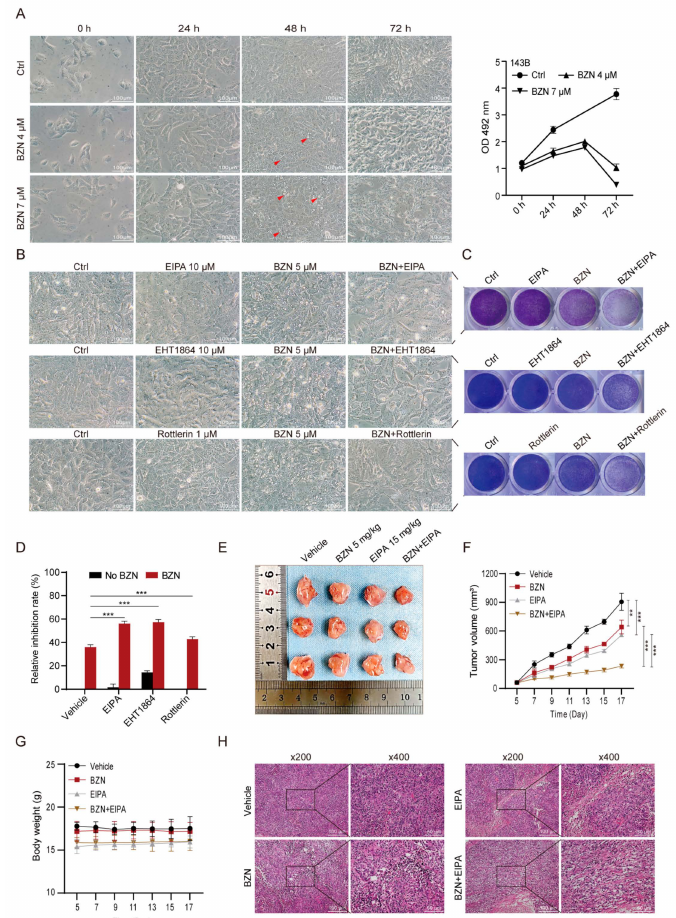
Figure 8. Macropinocytosis inhibitors enhance the anti-proliferative effect of BZN in vitro and in vivo. ( A ) Phase-contrast images of 143B cells treated with BZN (4 or 7 µ M) at different time points (scale bars: 100 µ m) and their corresponding cell proliferation (MTT). The red arrows refer to the cytosolic vacuoles. ( B ) The effect of EIPA, EHT1864, or rottlerin on BZN-induced macropinocytosis (scale bars: 100 µ m). ( C ) The effect of EIPA, EHT1864, or rottlerin on the proliferation of 143B cells (crystal violet staining). ( D ) The effect of EIPA, EHT1864, or rottlerin on the proliferation of 143B cells (MTT). ( E ) Representative images of OS samples retrieved from the control group, BZN (5 mg/kg) group, EIPA (15 mg/kg) group, and combination group. ( F ) The tumor volume of the xenograft tumor. ( G ) The body weights of the xenograft mice. ( H ) H&E staining of retrieved OS samples ( × 200, × 400). Data are shown as mean ± SD from three independent experiments. ** p < 0.01 and *** p <